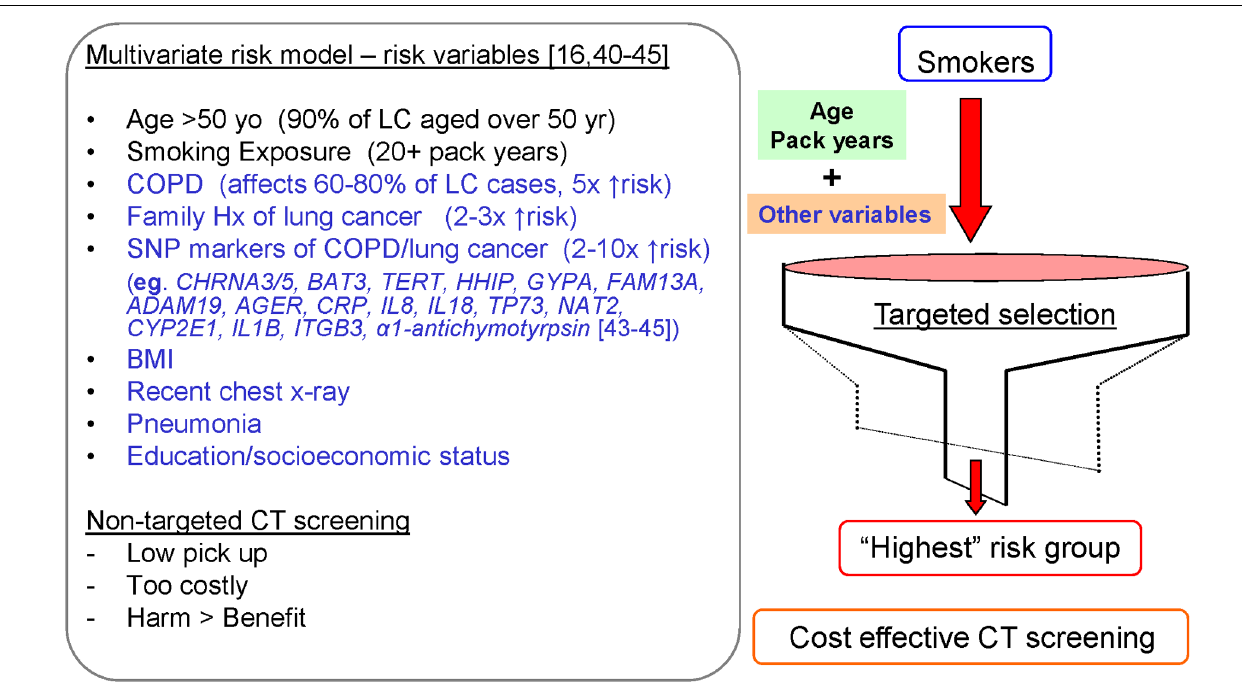
FIGURE 2 | Multivariate risk model to identify current and former smokers at greatest risk of lung cancer for targeted, cost-effective CT